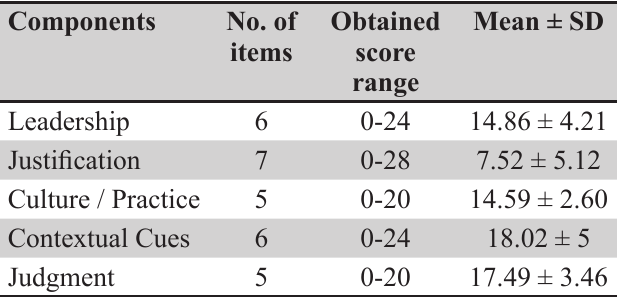
Table 2: Scores obtained by participants in different factors influencing adherence to stanadrd precautions (N=191)